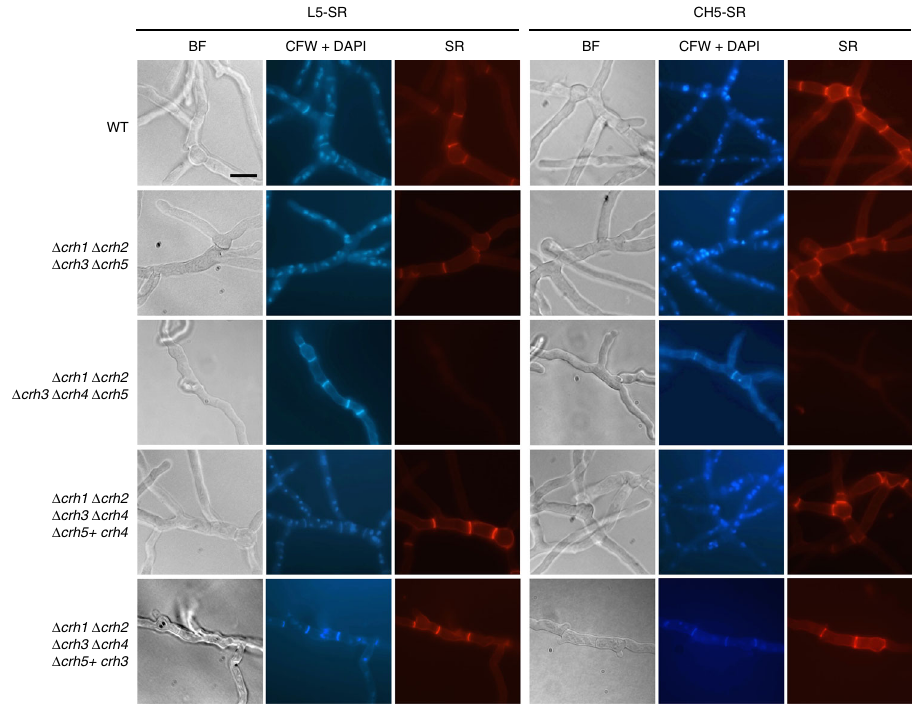
Fig. 1 Incorporation of different SR-oligosaccharides is blocked in the quintuple crh mutant. 10 5 conidia of WT and the indicated strains were incubated with 3.75 µ M of SR-labelled laminaripentaose (L5-SR) or SR-labelled penta-acetyl chitopentaose (CH5-SR) for 16 h at 37 °C. Cells were fi xed and stained with 10 µ g ml − 1 DAPI and 10 µ g ml − 1 CFW before being analysed by fl uorescence microscopy. Panels (from left to right) were the same cells under bright fi eld (BF), UV channel (CFW + DAPI) and the rhodamine fl uorescence channel (SR), as indicated. All images were taken at the same exposure. Scale bar, 10 µ